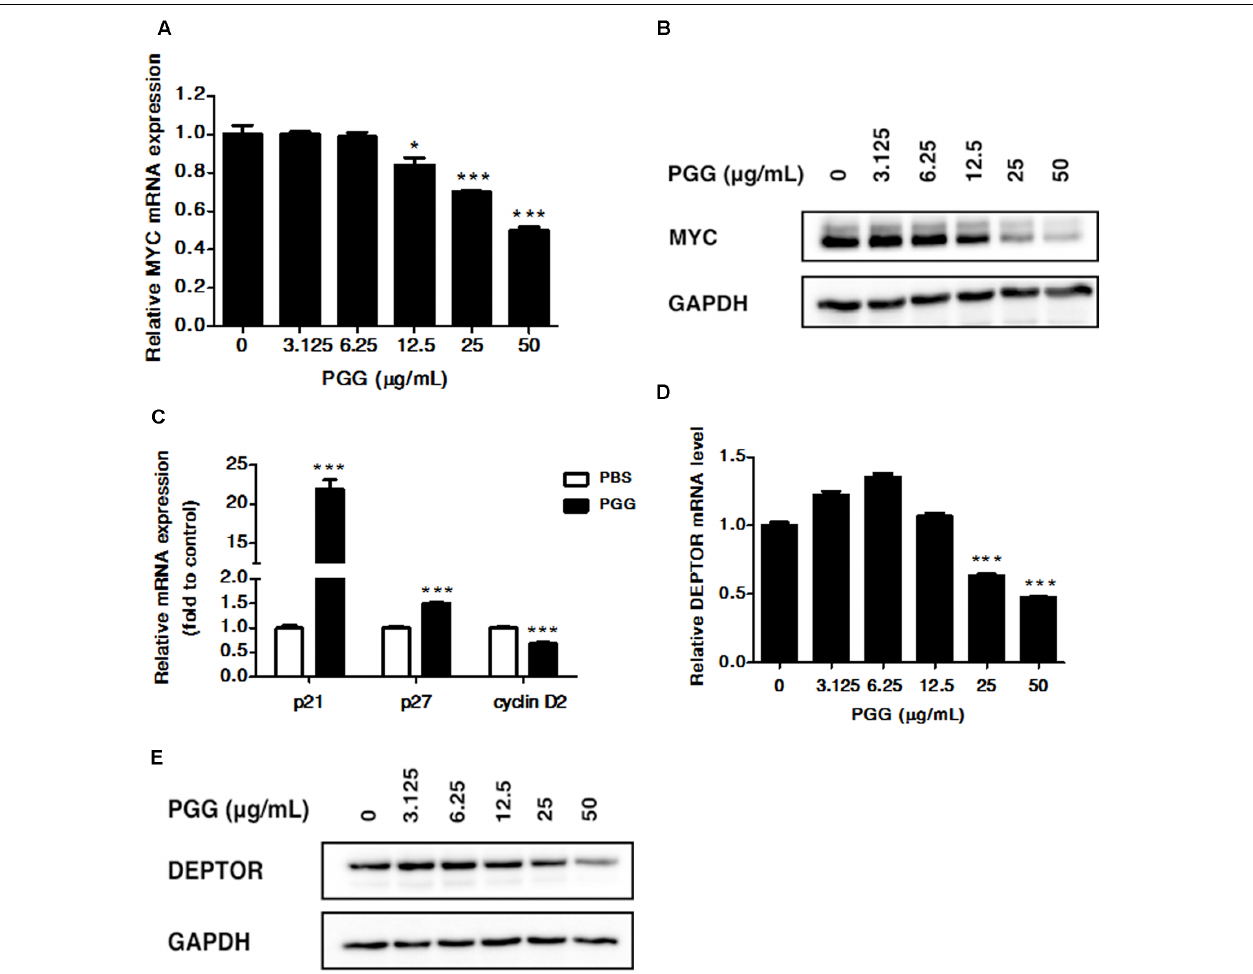
FIGURE 2 | PGG inhibits MYC and DEPTOR expression. (A,B) RPMI 8226 cells were treated with indicated doses of PGG for 24 h. mRNA (A) and protein (B) expression of MYC was detected by quantitative real-time PCR (qRT-PCR) and immunoblotting assay. Results are means ± SD ( n = 3). GAPDH expression was used as loading control. (C) The mRNA levels of MYC target genes (p21, p27, and cyclin D2) after 24 h of PGG treatment in RPMI 8226 cells were detected by qRT-PCR. Data presented as fold to solvent control. The graph shows the means ± SD ( n = 3). Effect of PGG on DEPTOR mRNA (D) and protein (E) expression in RPMI 8226 cells after 24 h of treatment. GAPDH expression was used as a loading control. Results are the means ± SD ( n = 3). ∗∗∗ P < 0.001, ∗ P < 0.05 (Student’s t